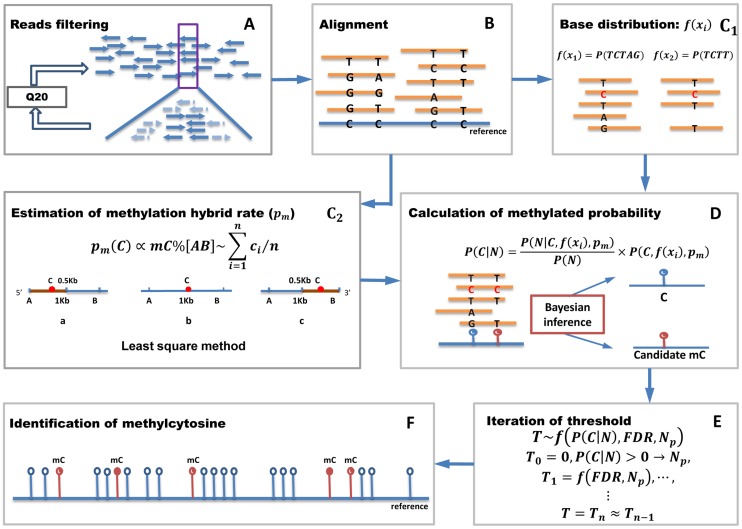
Overview of the Bycom workflow for methylcytosine calling.(A) Low quality reads filtered by Q20 value. (B) Filtered reads mapped to the reference genome. (C) Base distribution  (C1) and methylation hybrid rate Pm (C2) were estimated from the mapping results. Pm was evaluated from the methylation level of a 1000-bp region centered on selected cytosine sites. For cytosine sites in the 500-bp head or tail of a chromosome, Pm was calculated as the average methylation level of the 1000-bp head or tail of the chromosome. (D) Based on the  and Pm, the true positive sites were identified as candidate methylcytosines using a Bayesian inference model from the false positive sites with methylation levels above zero. (E, F) Methylcytosines identified using iteration of a set threshold.